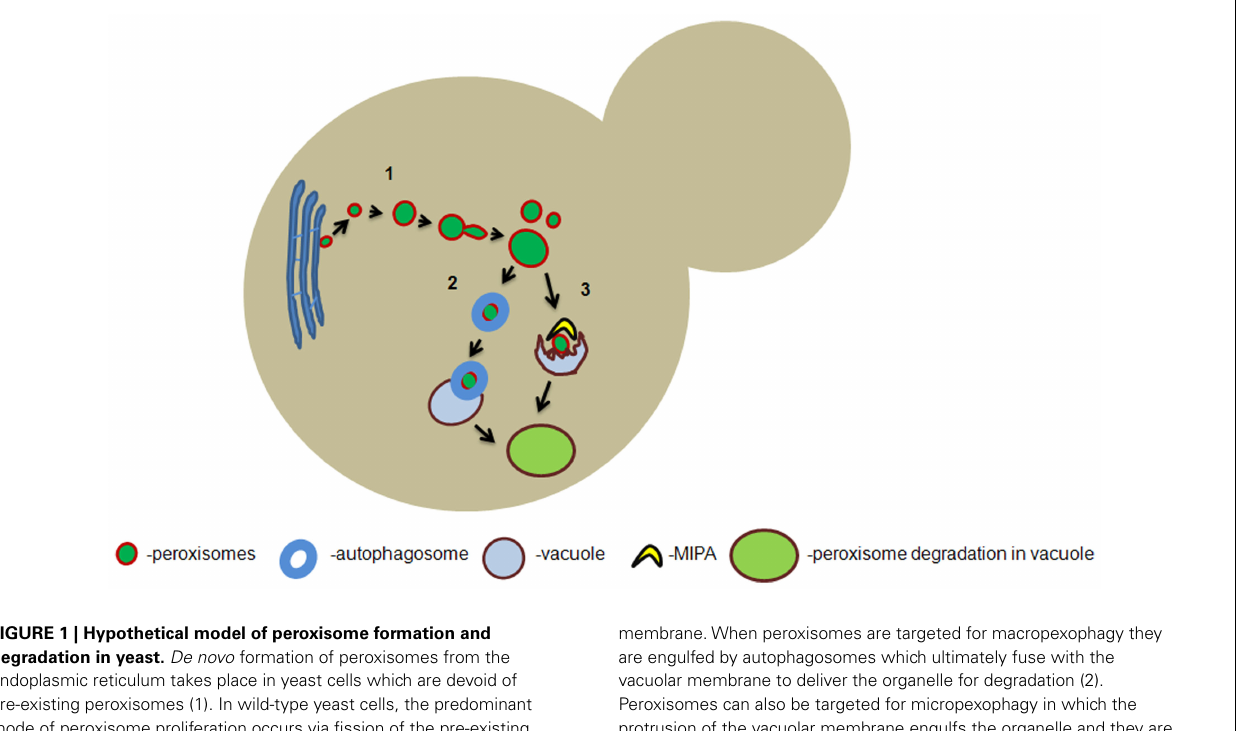
FIGURE 1 | Hypothetical model of peroxisome formation and degradation in yeast. De novo formation of peroxisomes from the endoplasmic reticulum takes place in yeast cells which are devoid of pre-existing peroxisomes (1). In wild-type yeast cells, the predominant mode of peroxisome proliferation occurs via fission of the pre-existing organelles which involves Pex11p dependent elongation and dynamin-related protein (DRP) dependent scission of the peroxisomal